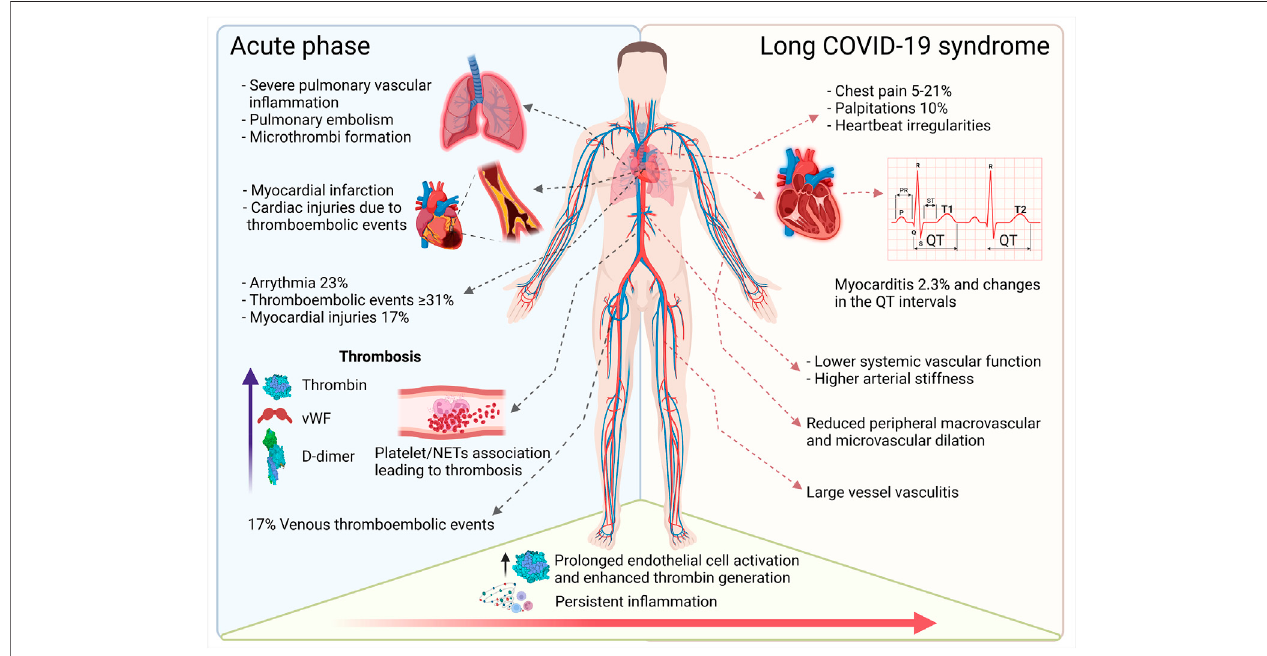
FIGURE 2 | Overview of cardiovascular complications in acute and long-term COVID-19. The acute phase of COVID-19 induces pulmonary, cardiac, and peripheral thrombotic events and can trigger arrythmia and myocardial injury. Persistent in fl ammation and accompanying vascular dysfunction foster cardiac complications such as palpitations and myocarditis. Ongoing (chronic) vascular in fl ammation increases vascular stiffness and reduces micro- and macrovascular dilatation (This fi gure was made with biorender.com).